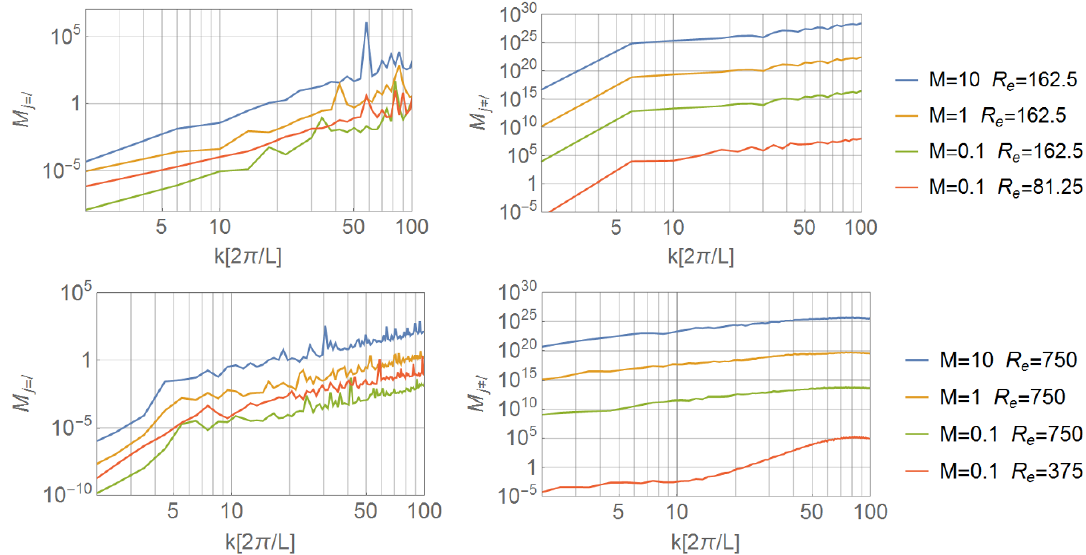
R dk p jF [ @ R dk p jF [ @ 2 and @ 2 denoted Figure 22 . The relation between @ j ( @ ‘ a=a )] j j ( f ‘ =a )] j @k @k by M j‘ for three dimensional turbulent (cid:13)ows. Above, M j‘ for the (cid:13)ows with initial mode n = 4 appearing in (cid:12)gure 20 at time t = 0 : 45 (cid:28) . Below, M j‘ for the (cid:13)ows with initial mode n = 1 appearing in (cid:12)gure 21. The right plots shows the typical relation for the diagonal terms M j = ‘ . The left plots depicts the typical relation for the o(cid:11) diagonal terms M j 6 = ‘ . The variance between Mach numbers, rather high or low appears almost linear on the log scale for M j 6 = ‘ , and is drastically di(cid:11)erent from the two dimensional (cid:13)ows on (cid:12)gure 18. This is responsible for the lack of accuracy of the relation (6.12). The aforementioned variance between Mach numbers leads to the conclusion that a much lower Mach number than M (cid:24) 0 : 1 is required in order to drop high order derivative terms in